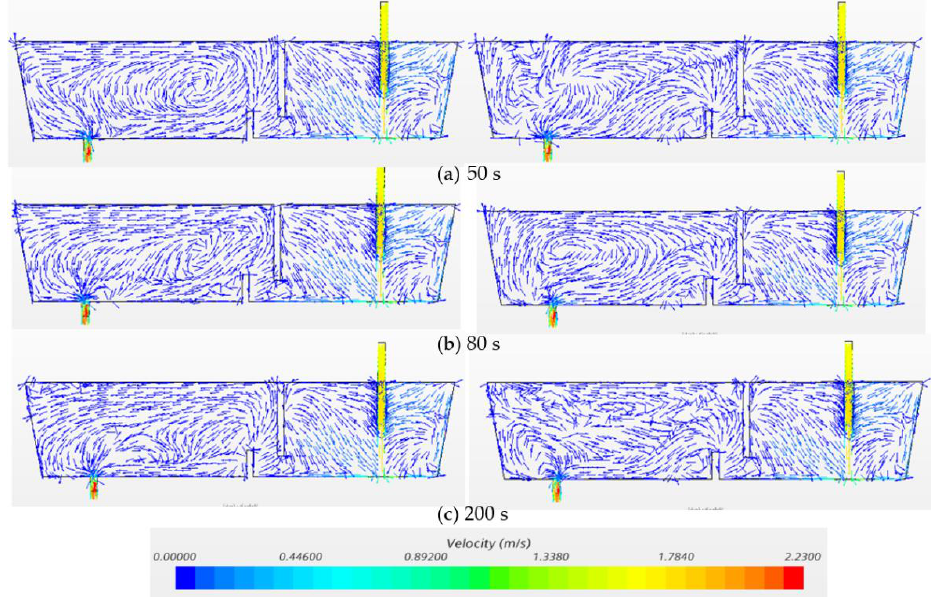
Figure 10. Velocity at symmetry plane under transient non-isothermal conditions in water model with FCD (Q = 2000 l/h, H = 0.4 m, left: ΔT = 20 °C, right: ΔT = −20 °C). ( a ) 20 s, ( b ) 80 s, ( c ) 200 s. with FCD (Q = 2000 l/h, H = 0.4 m, left: ∆ T = 20 ◦ C, right: ∆ T = − 20 ◦ C). ( a ) 20 s, ( b ) 80 s, ( c ) 200